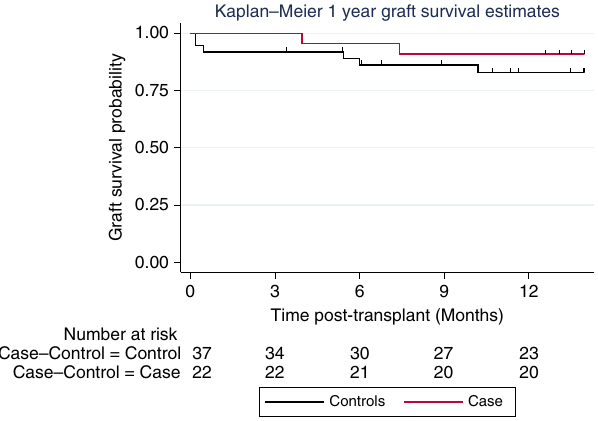
Fig. 5 Comparison of 1-year graft survival estimate. Conditional logistic regression was carried out on the matched case – control data to determine the relative risk for graft survival at 1 year between matched case – control groups. The median (range) days follow-up data were included in the survival analyses, but the plot was truncated at 12 months. The ticks on the top of each Kaplan – Meier curve relate to the numbers of patients being censored at that particular time point. There are 2 cases of graft failure in the perfusion group at days 119 and 209; the control group contains 5 graft failures (2 at day 5, 1 at day 14, 1 at day 165 and 1 at day 182). The graft survival was similar in both groups. Findings showed that the odds ratio (relative risk) estimate for graft survival at 6 months was determined as